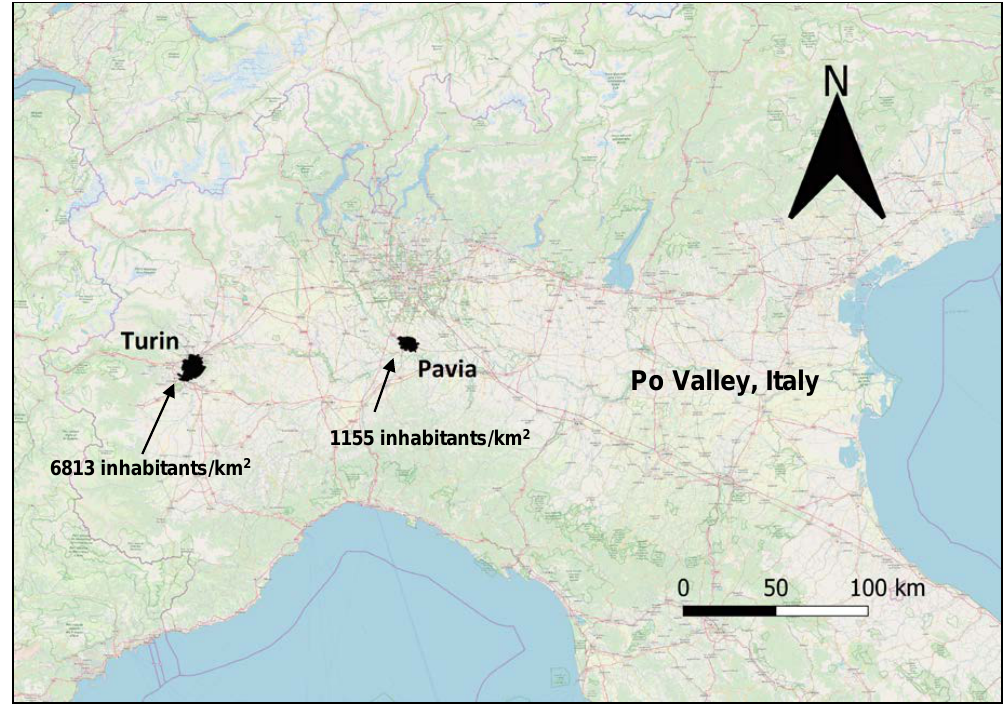
Figure 1. Map showing study area. The human density of the two cities, about 160 km apart, is reported as inhabitants per square kilometre.